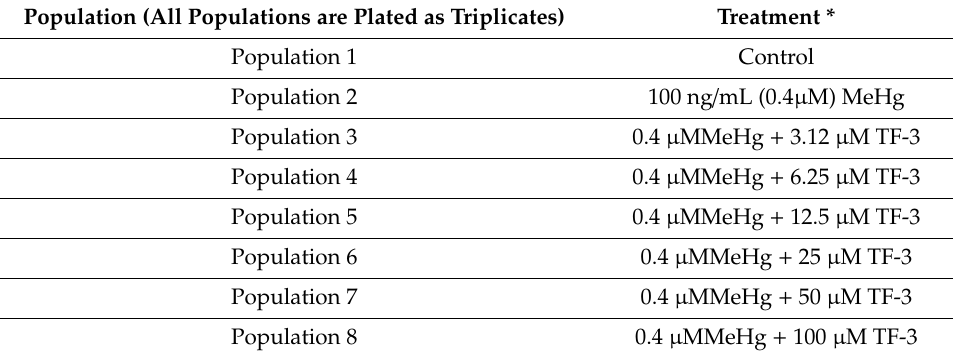
Table 1. List showing study groups of di ff erent populations.